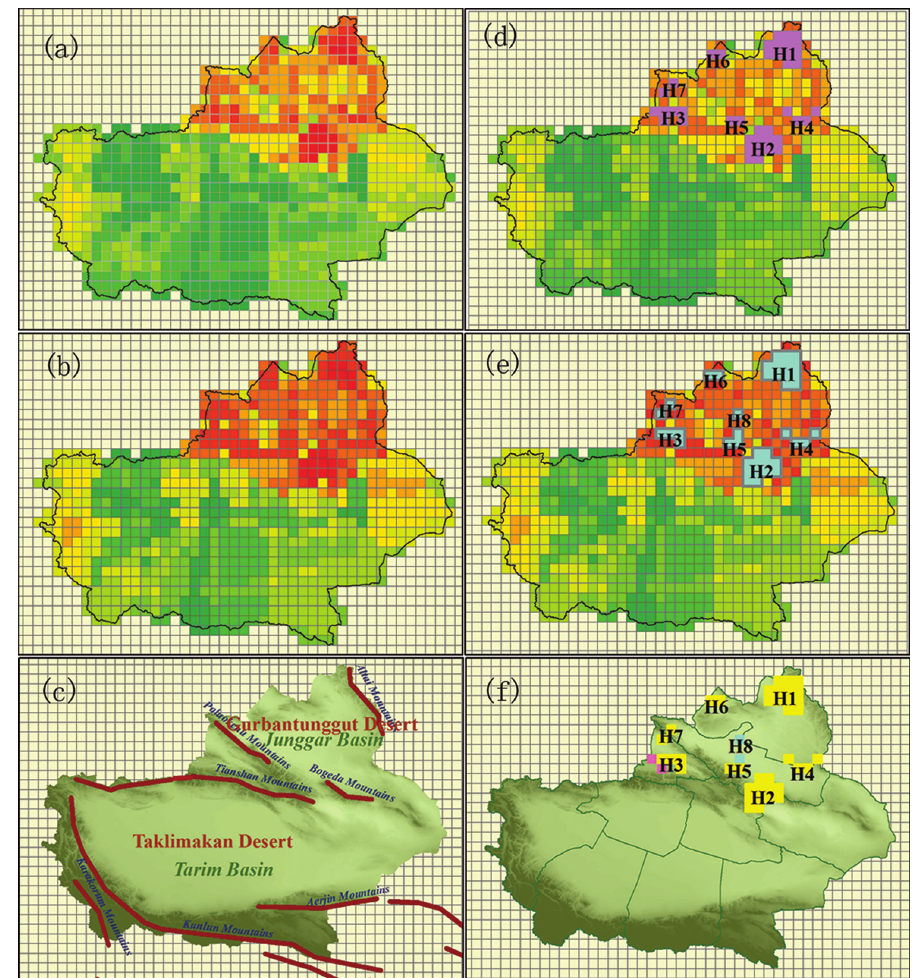
Figure 3. Geographic distribution of Xinjiang seed plant diversity patterns and hotspots and major moun- tains ranges in northwest China. a Geographic distribution of species richness b geographic distribution of phylogenetic diversity c major mountains ranges d diversity hotspots identified by species richness e diversity hotspots identified by phylogenetic diversity and f diversity hotspots identified by both species richness and phylogenetic diversity. Albers projection. Hotspot centre codes are consistent with those listed in Table 3